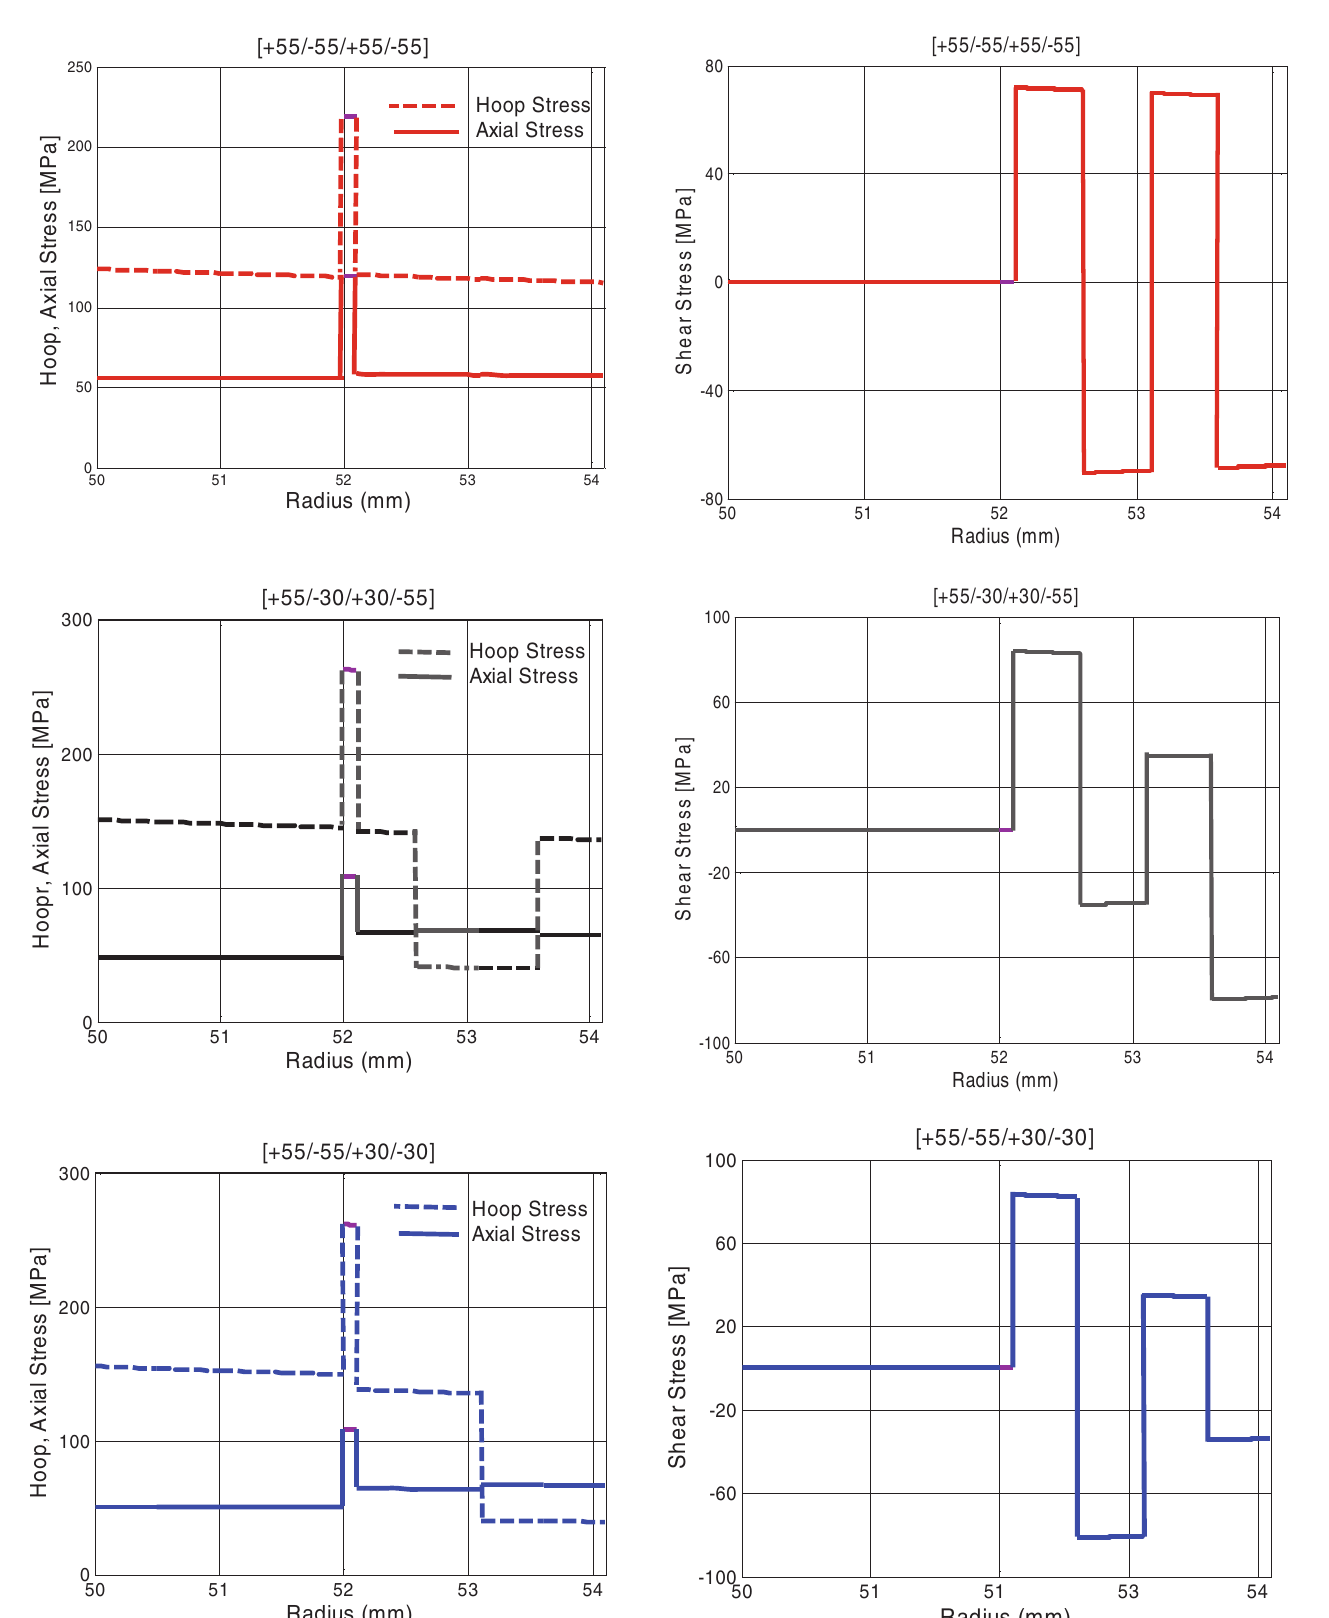
Fig. 2. The distribution of Hoop and axial stress through the thickness.